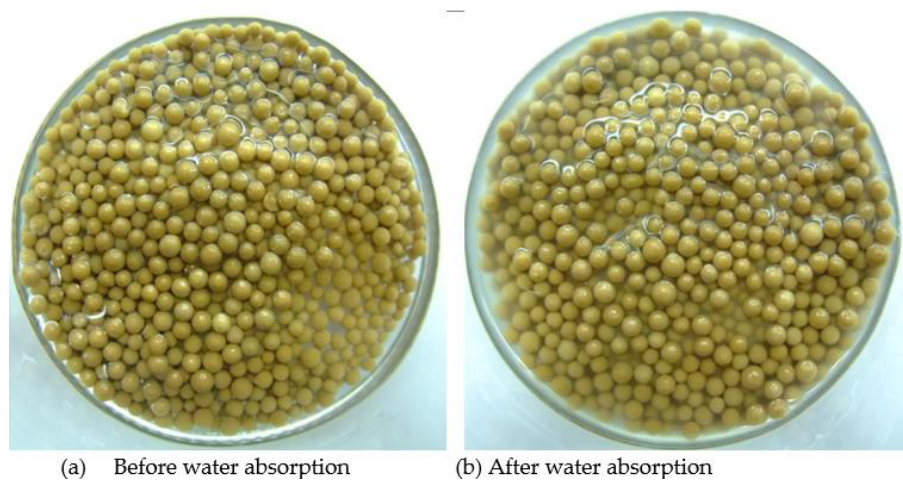
Figure 2. A comparison of the appearance of molecular sieves ( a ) before water absorption and ( b ) after water absorption from palm oil accompanied by electromagnetic stirring.